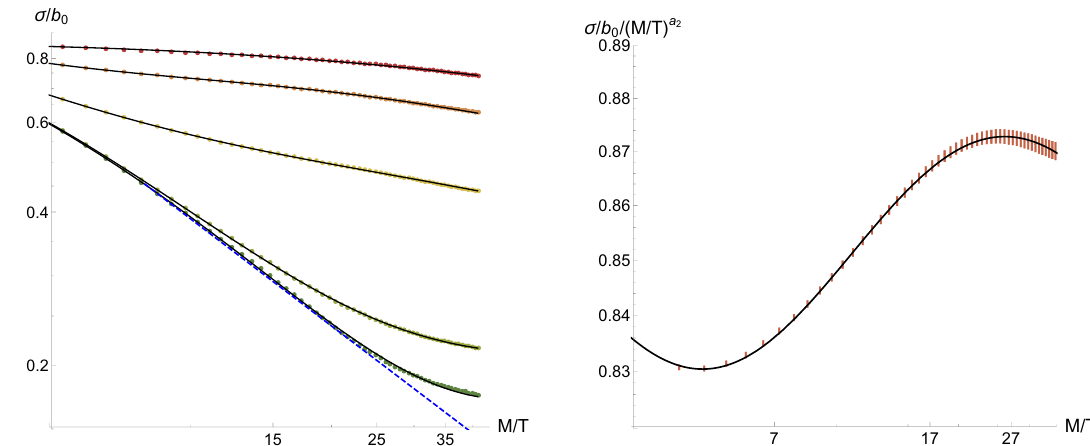
Figure 10 . Left: log-Log plot at the critical point (cid:22) b 0 = 1 : 4023 with increasing disorder strength (cid:22) (cid:13) = (0 : 003 (cid:0) 0 : 6) (green-red). For high enough disorder the data (cid:12)t well to a log-oscillatory function of the type: t ( x ) = a 1 x a 2 (1 + a 3 sin [ a 4 log( x ) + a 5 ]) (black lines). At low disorder (green line) the data approximates the power law decay found at zero disorder and shown in blue-dashed line. Right: data at (cid:22) (cid:13) = 0 : 4 (orange line in the left panel), divided by ( M=T ) a 2 with exponent a 2 given by the (cid:12)t. Oscillations become